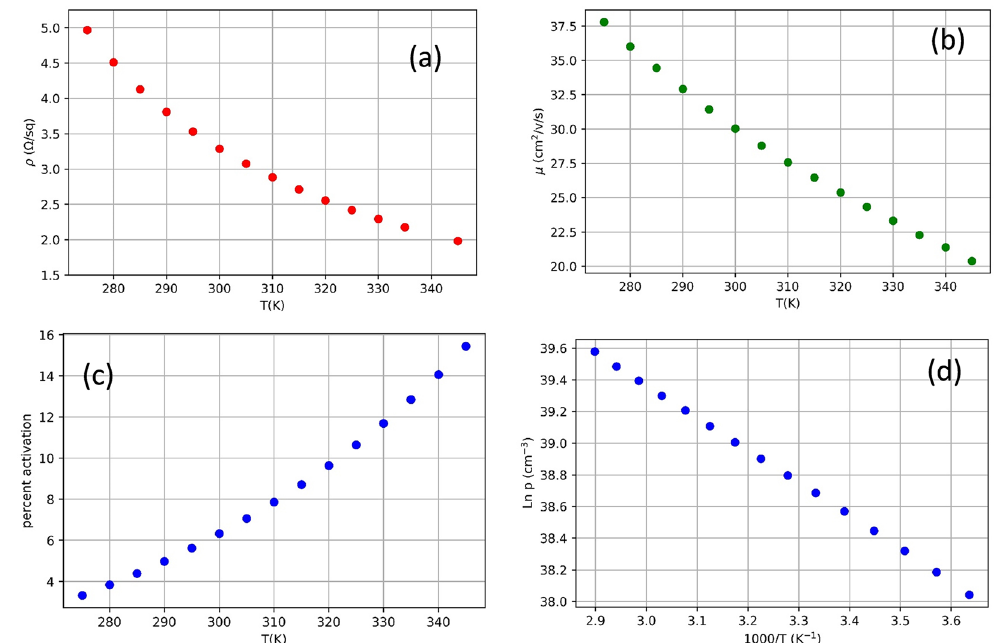
Figure 2. The resistance ( a ), hole mobility ( b ), and the hole concentration ( c – d ) are taken as a function at temperature ranging from 275 to 345 K. The hole concentration is in units of percentrage of the Mg atoms activated with 100% activation = 10 18 cm −3 . ( d ) The hole concentration is plotted on Ln(p) vs 1000/ T scale to show lineararity.